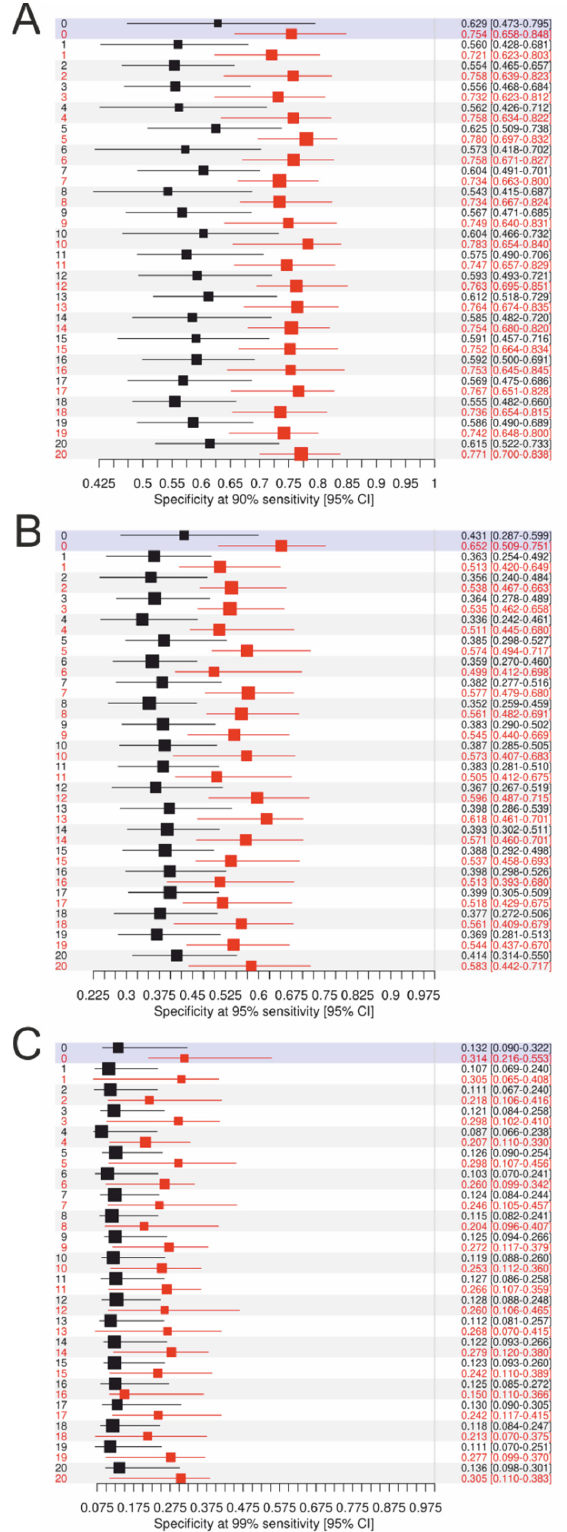
Figure 5. Specificities (95% CI) of CA125 (black) vs. the models (red) at a set sensitivity of ( A ) 90%, ( B ) 95%, and ( C ) 99%, respectively. Y -axis, number of imputed datasets; 0, the complete